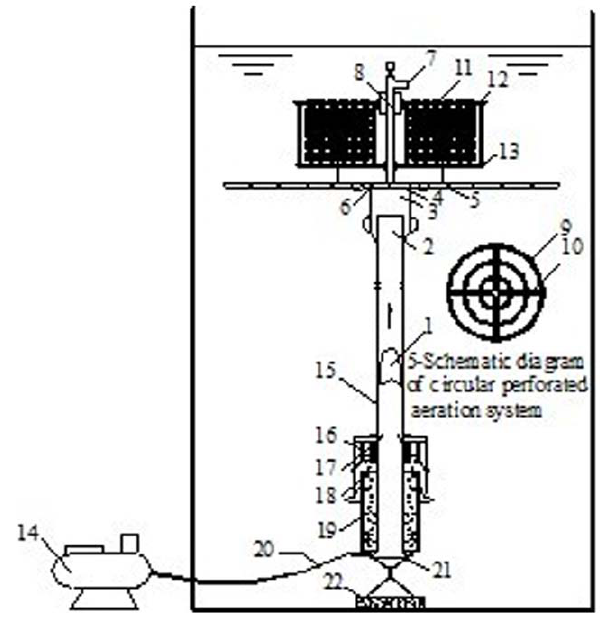
Figure 1. Schematic representation of the pilot experiment. 1- aeroelasticity;2-outlet;3-aeroelasticity collective chamber;4-perforated regulator plate;5-cyclic aeration system;6-pressure stabilization cham- ber;7-valve;8-voltage regulator pipe;9-aeration branch (DN15);10-aera- tion trunk (DN15);11-float;12-suspended carrier;13-filler bracket;14-air compressor;15-up-flow cylinder;16-watertight compartments;17-air chamber;18-back flow chamber;19-aeration chamber;20-inlet pipe;21- air releaser;22-anchor block.